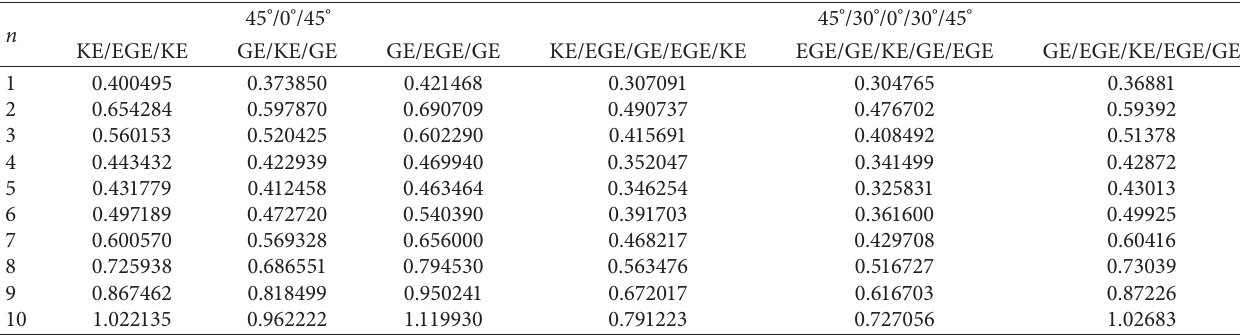
Table 2: Influence of circumferential node number on the fundamental frequency parameter of three- and five-layered conical shells with different material combinations.